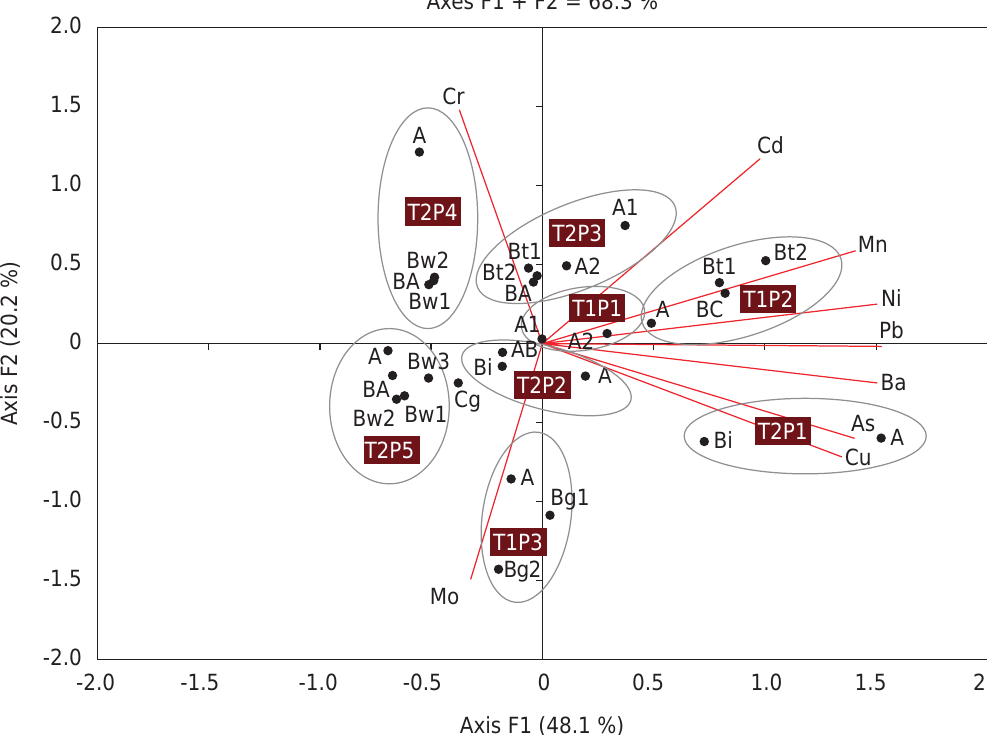
Figure 3. Principal component analysis (PCA) of the potentially toxic elements (PTE) of soil horizons and classes of profiles from the Montes Claros microregion, MG,